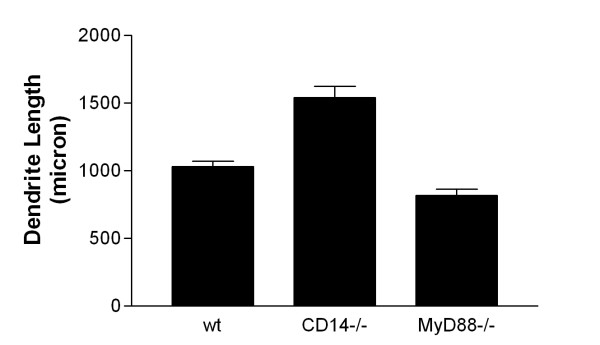
Dendritic arbor in CA1 pyramidal neurons of hippocampus from knockout mice. Adult (6 to 8 week old) wt C57Bl/6, CD14-/-, or MyD88-/- mice received ICV saline 24 hr prior to sacrifice. Tissue sections of hippocampus and surrounding structures were processed for Golgi stain and then evaluated by Neurolucida. Data are dendrite length for CA1 hippocampal pyramidal neurons (n > 15 neurons for each group). One-way ANOVA had P < 0.0001 with Bonferroni-corrected repeated pair comparisons having *P < 0.001 for wt vs. CD14-/- and CD14-/- vs. MyD88-/-.